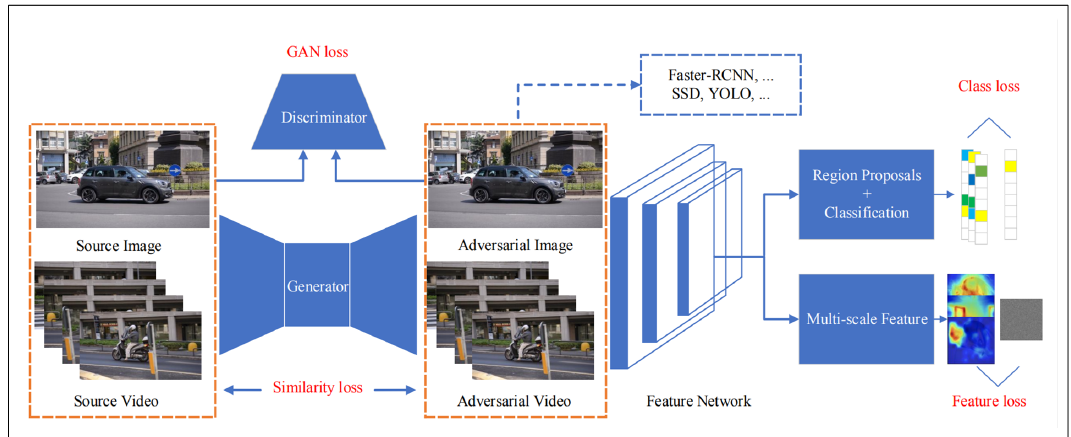
Figure 7. The overall framework of the Unified and Efficient Adversary (UEA). They formulate the high-level class loss [45] with the proposed low-level multi-scale feature loss into GAN framework to jointly train a better generator. For the coming images or video frames, the generator is to output the corresponding adversarial images or frames to simultaneously fool the different kinds of object detectors (Image Credit: Wei et al.